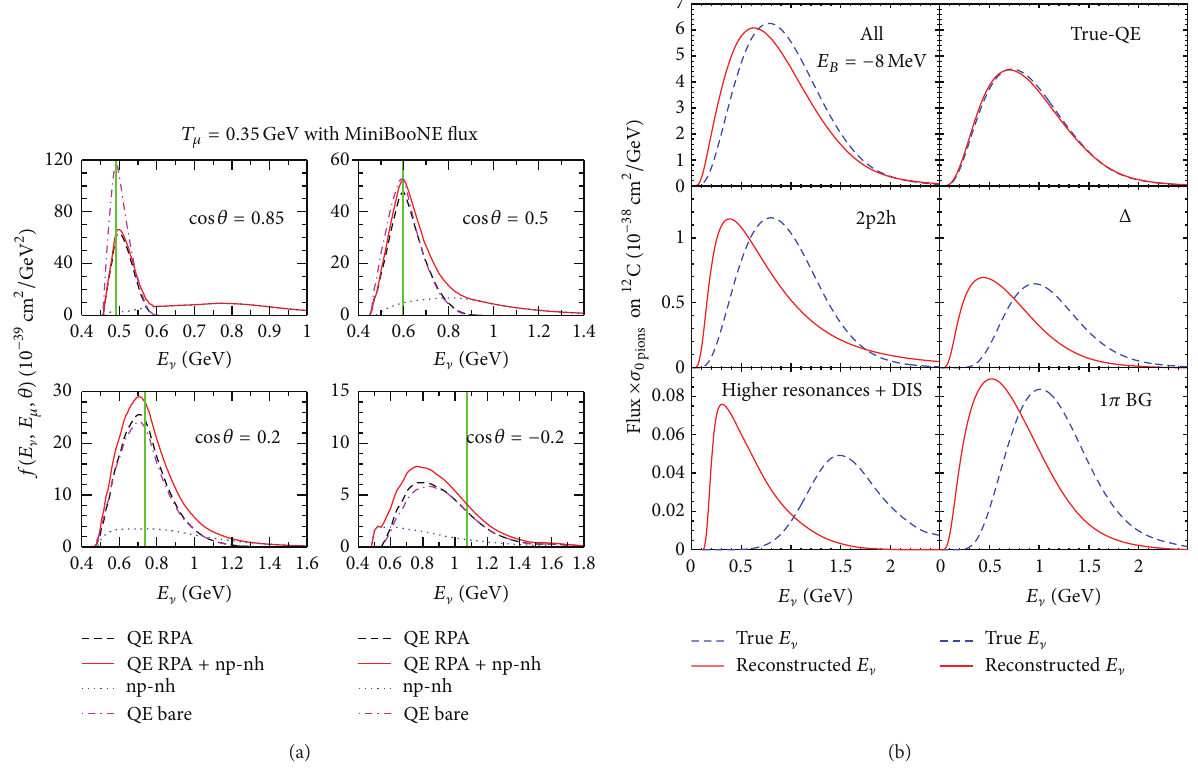
Figure 10: (a) Neutrino energy distributions at 𝑇 𝜇 = 350 MeV, computed at different muon scattering angles using the MiniBooNE flux [53]. The vertical lines correspond to the reconstructed 𝐸 ] of (46). (b) Event distribution of zero pion events in the MiniBooNE experiment. The dashed curves show the distributions Φ(𝐸 ] )𝜎 0𝜋 (𝐸 ] ) , defined as in (49), corresponding to different reaction mechanisms, while the distributions Φ(𝐸 rec ] )̃𝜎 0𝜋 (𝐸 rec ] ) are displayed as solid lines